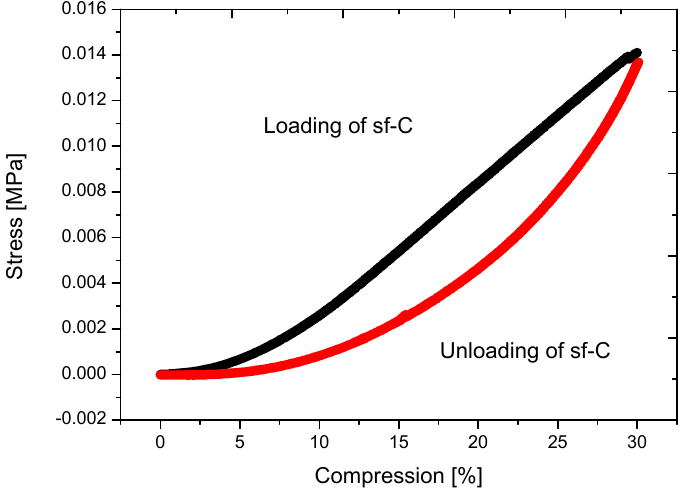
Figure 12. Loading and unloading curves of the super-flexible carbon aerogel showing reversible deformation after 30% compression.